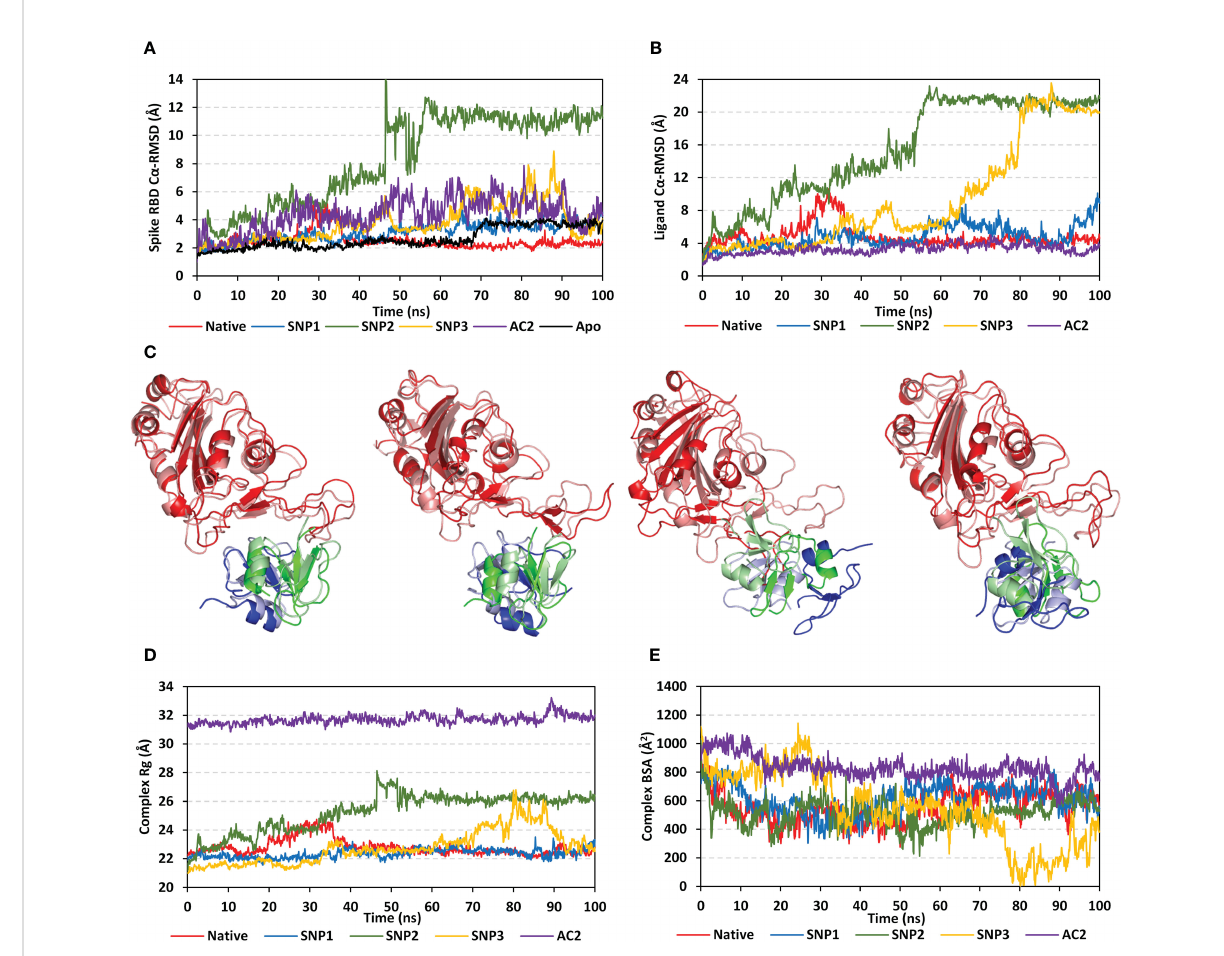
FIGURE 5 Stability analysis of the simulated spike RBD/ligand complexes across the molecular dynamics simulations. (A) Spike RBD C a -atom RMSDs; (B) ligand C a -atom RMSDs, as a function of the simulation times (ns). (C) Overlaid spike RBD/ h BD-2 complex snapshots at 0 and 100 ns for native, SNP1, SNP2, and SNP3 ligand proteins from the left to the right side, respectively. Proteins are represented as cartoons and colored red, blue, and green for respective spike RBD, h BD-2 protomer A, and h BD-2 protomer B domains. Initial and fi nal extracted frames were represented in faint or dark colors, respectively. (D) Complex Rgs; (E) Complex BSAs, as a function of the simulated times